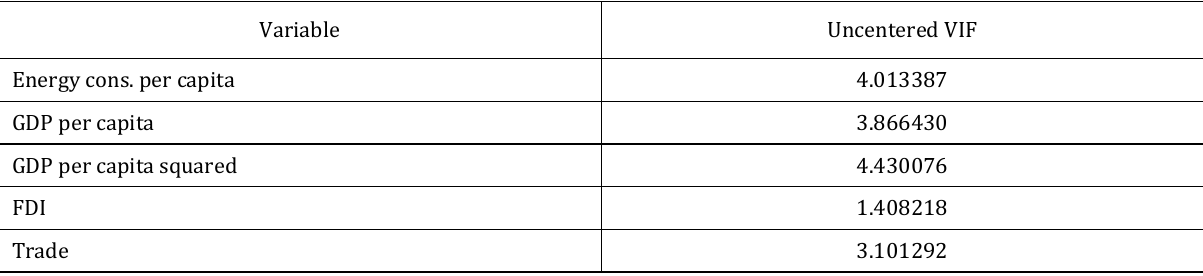
Table A3. Results of Variance Inflation Factor (VIF) (source: author’s estimations using EViews 9)